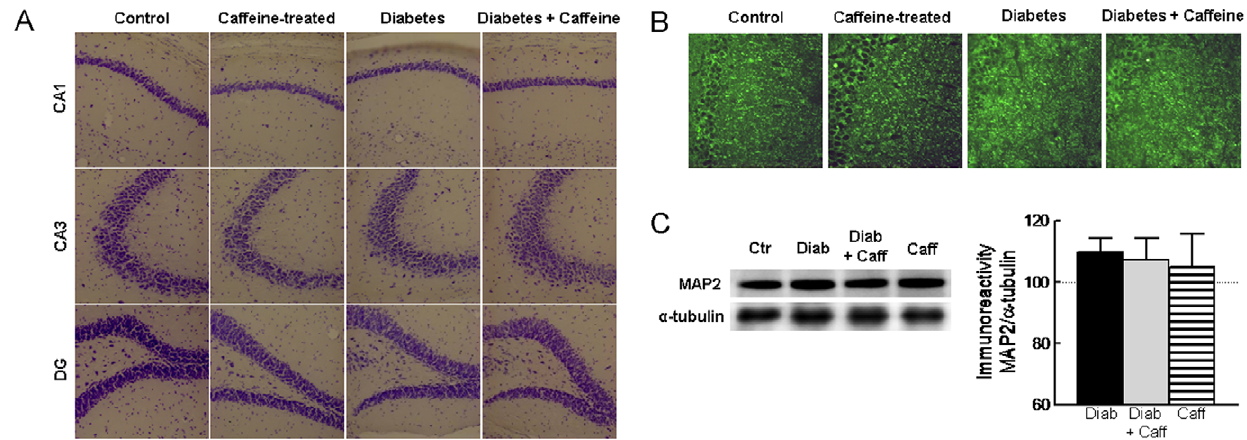
Figure 2 . Lack of structural alterations in the hippocampus of diabetic mice . Diabetic NONcNZO10/LtJ mice did not present structural alterations in the hippocampus when evaluating Nissl bodies stained with cresyl violet in the dentate gyrus (DG), CA1 and CA3 regions (A). Neither diabetes nor caffeine consumption affected MAP2 immunoreactivity as evaluated by immunohistochemisty in CA1 area (B) and Western blot analysis (C, n=6). In C, the immunoreactivity was normalised to that of a -tubulin in the same membranes and calculated as percentage of control. Black, grey and striped bars represent diabetes (Diab), diabetes plus caffeine and caffeine (Caff) groups, respectively. Data in panels (A) and (B) are representative of 4 animals per group and in panel (C) the data are mean 6 SEM of n=5–6 mice in each experimental group.